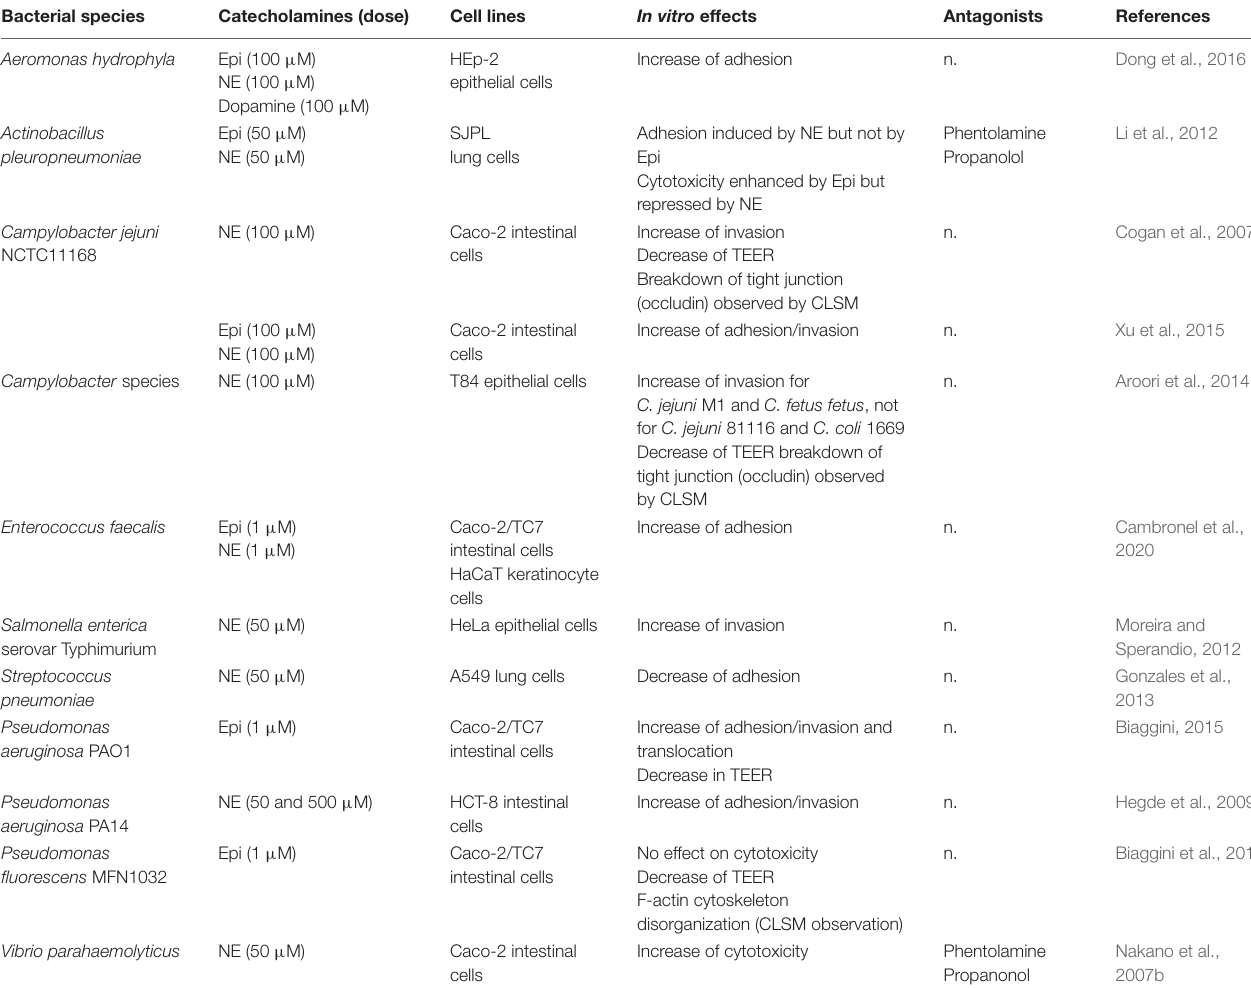
TABLE 5 | In vitro bacterial effects in presence of catecholamines (adhesion/invasion, cytotoxicity). Bacterial